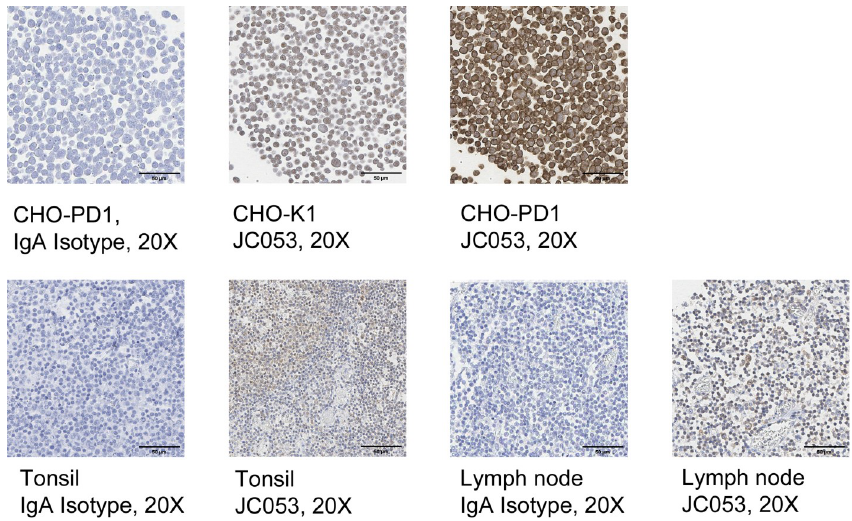
Fig 7. Detection of PD-1 expression on formalin-fixed cells and FFPE tissues by anti-canine antibody JC053. JC053 was tested for evaluation of PD-1 expression on formalin-fixed cells as well as canine tissues. CHO-K1 as well as CHO-PD1 cells (A) were fixed with formalin, treated with Histogel and paraffin blocks were prepared. Cells were stained with JC053 (1:100 dilution) and compared to IgA isotype control stained cells (1:100 dilution) in IHC. FFPE tonsil and lymph node (B) were also evaluated for PD-1 expressions. JC053 was diluted at 1:1000 and IgA isotype control was diluted at 1:100. Images for JC053 are 40x magnified and IgA isotype control images are 20x magnified.